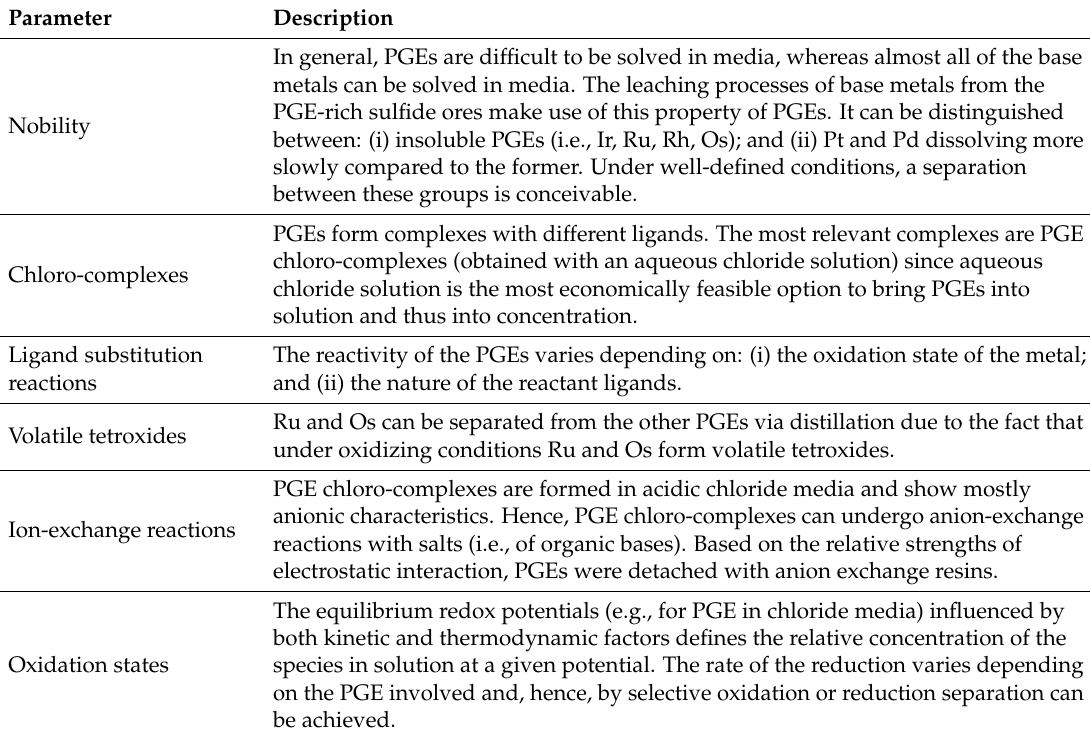
Table 2. Key aspects of properties and chemistry of PGEs for the separation processes during PGE refining